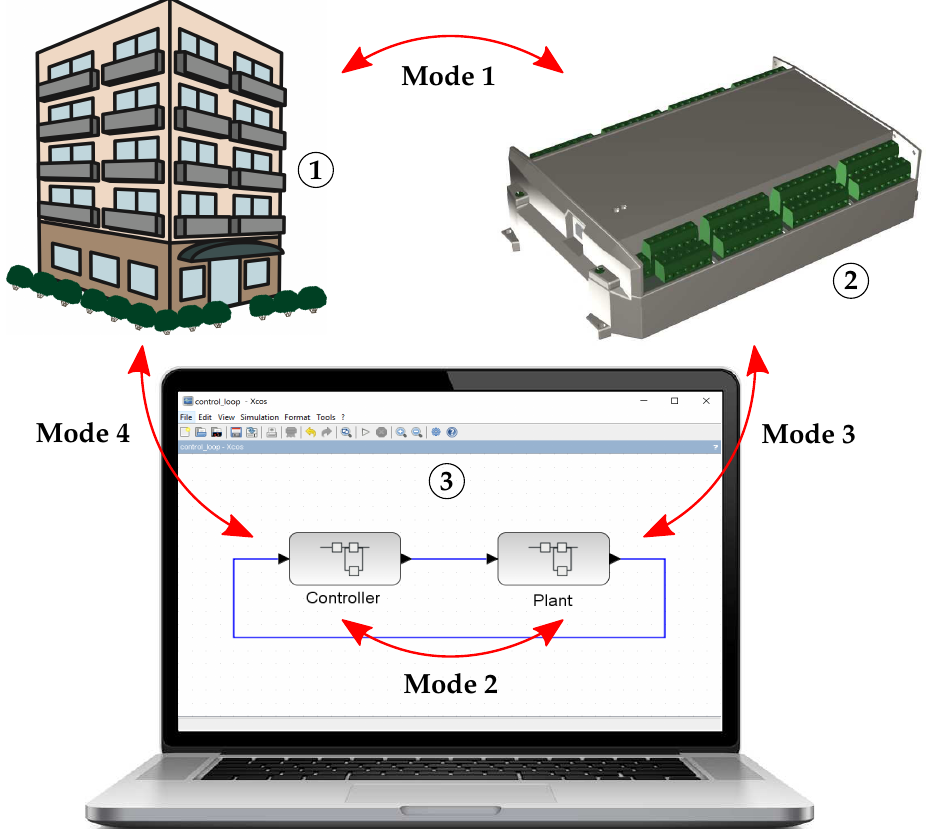
Figure 3. DCU control modes. 1 —real system/process; 2 —DCU controller; and, 3 —host PC with simulation platform. NOTE: Red arrows connect parts, which cooperate in specific control